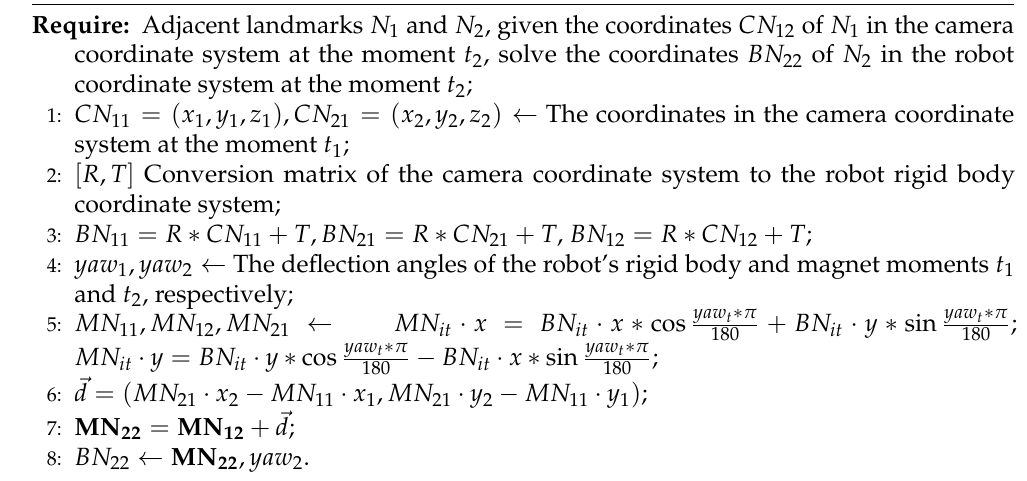
Figure 9. Illustration of the robot-centric relative topological association. ( a ) is the illustration of topological association information of the environment. ( b ) is the illustration of topological association based on the principle of coordinate invariance of vectors. Algorithm 1 Robot-Centric Relative Topological